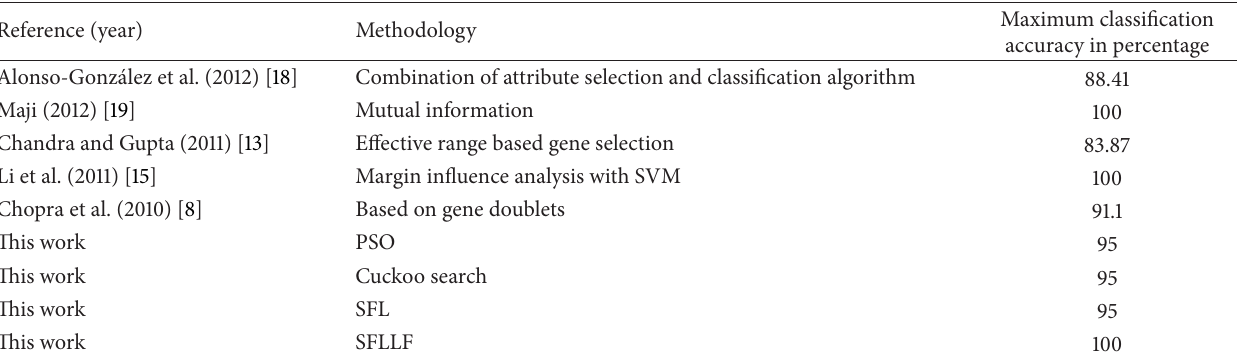
Table 11: Comparison of classification accuracy with other methods for Colon Tumor.